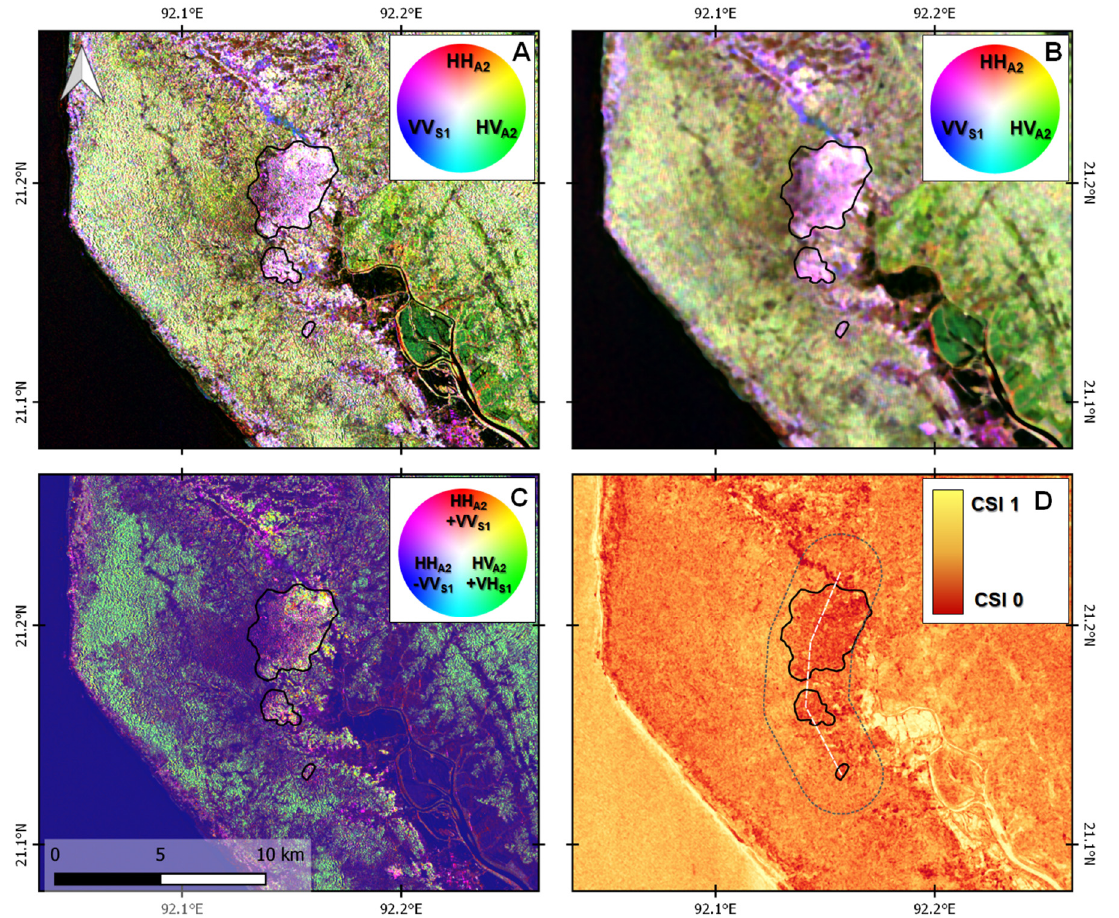
Figure 3. Selected SAR features in the study area (outlined by the red polygon in Figure 1) based on SAR data from March 2019. ( A , B ) composite HH (red), HV (green), and VV (blue) for filter images of 5 × 5 and 25 × 25 pixels; ( C ) combined indices CI1 (red, HH + VV), CI2 (green, HV + VH), and CI3 (blue, HH-VV); ( D ) Canopy Structure Index (red to yellow) for a median filter image of 9 × 9 pixels. Black line: camp outline in March 2019.